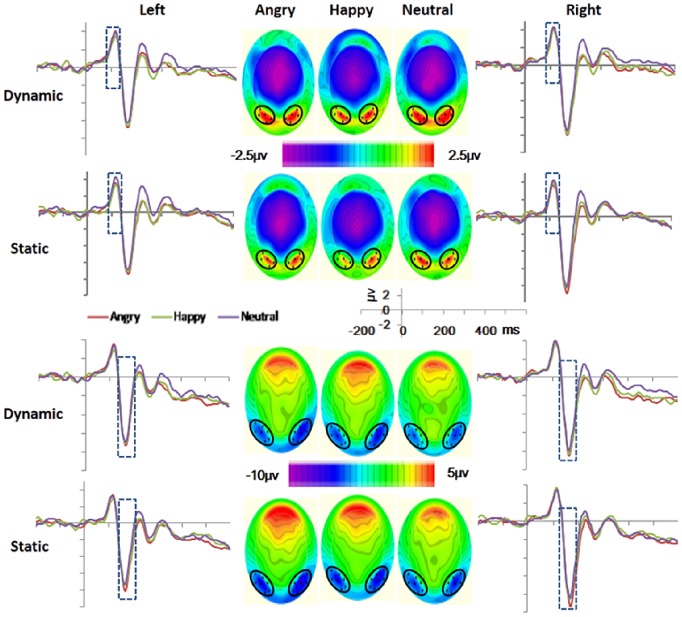
Waveforms and topographic maps (with nose up) for the P1 (top), and the N170 (bottom), showing grand averaged amplitudes at selected clusters of sensors.